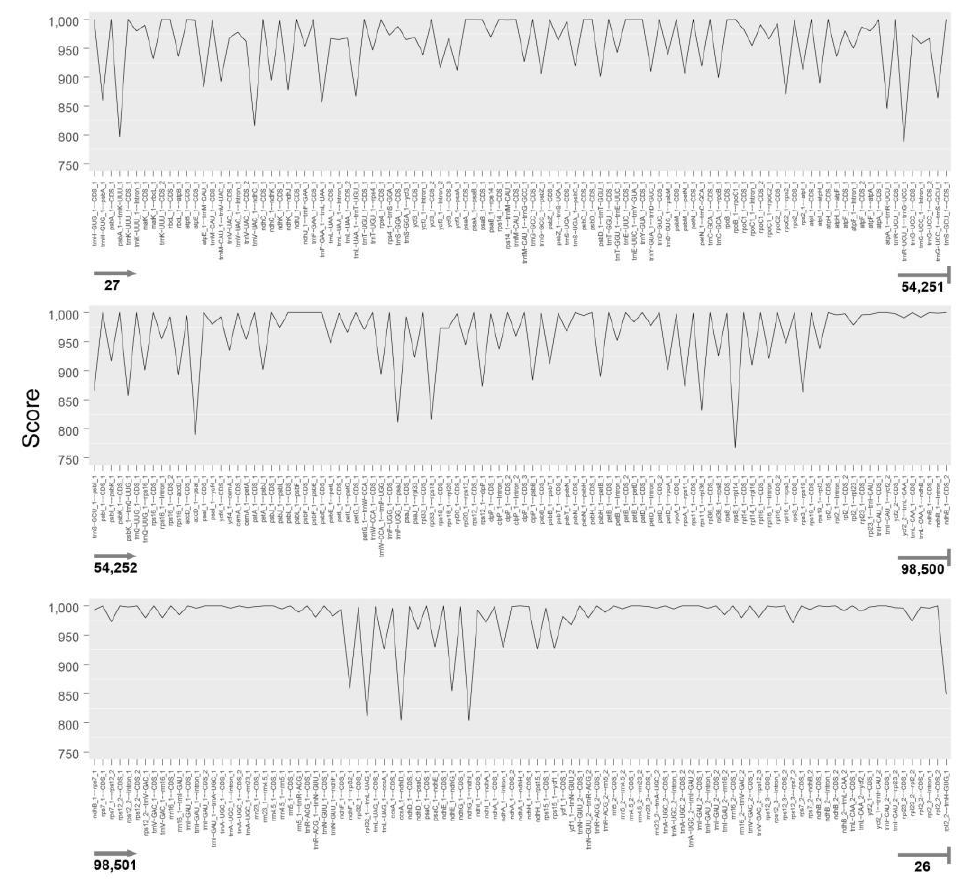
Figure 6. Sequence identity among coding and non-coding regions based on the alignment from 43 chloroplast genomes. T-Coffee was used to calculate the score of identity.